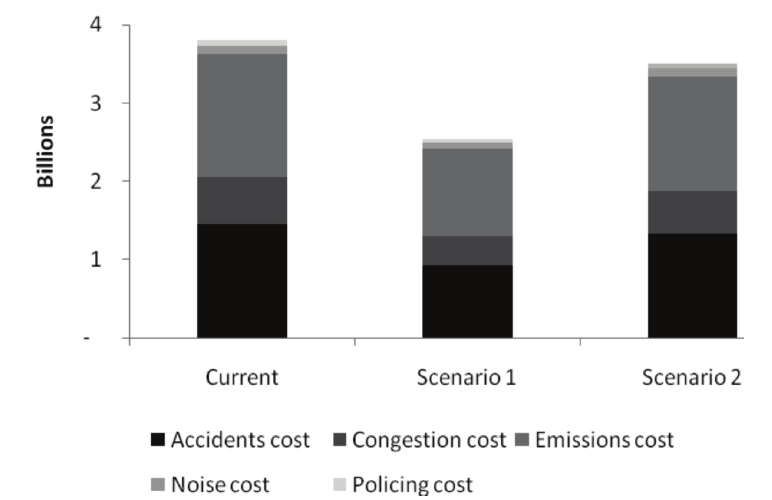
Figure 5: Comparative externality cost components: current vs. switching scenarios (data source: FDM, 2009, and CSCM Cost Model,